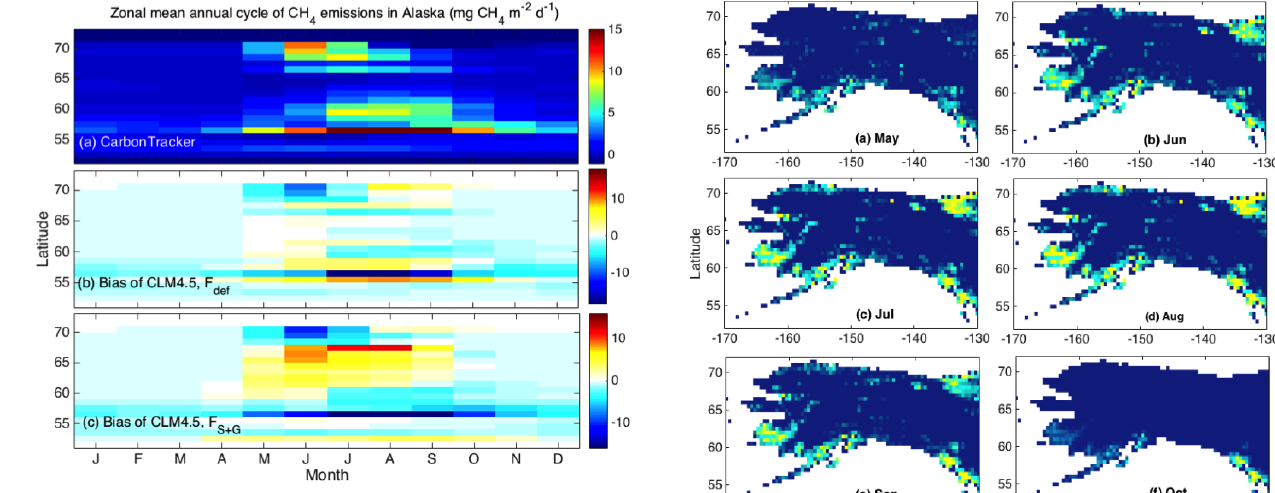
Figure 3. The 2000–2010 zonal mean annual cycle of CH 4 emis- sion (mgCH 4 m − 2 day − 1 ) across Alaska predicted by Carbon- Tracker (a) and biases of CLM4.5 with CLM4.5-predicted inunda- tion fraction ( F def ) (b) and SWAMPS-GLWD inundation fraction ( F S + G ; c ). The 0.5 ◦ × 0.5 ◦ CLM4.5 is regridded to 1 ◦ × 1 ◦ to be consistent with CarbonTracker.